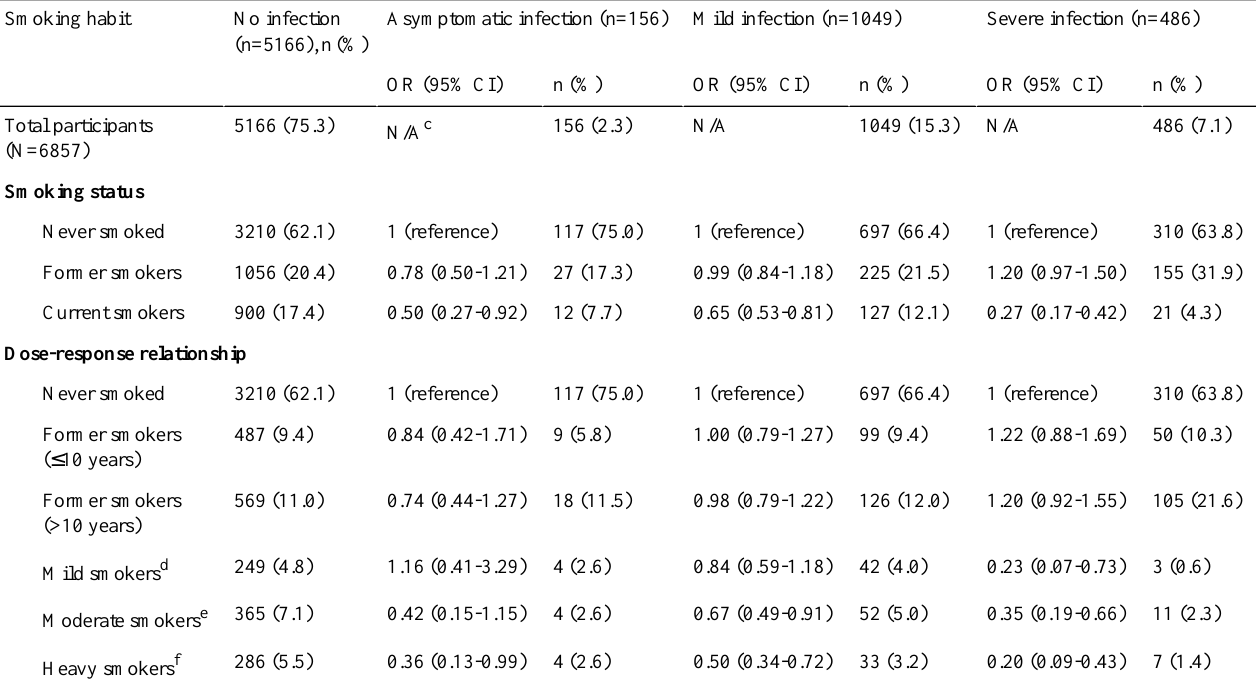
Table 4. Odds ratios (ORs) a of SARS-CoV-2 severity b by smoking habit (N=6857).